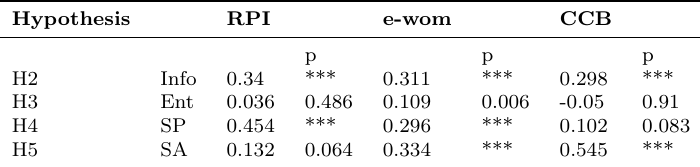
Table 4: Hypothesis testing for Experimental Group